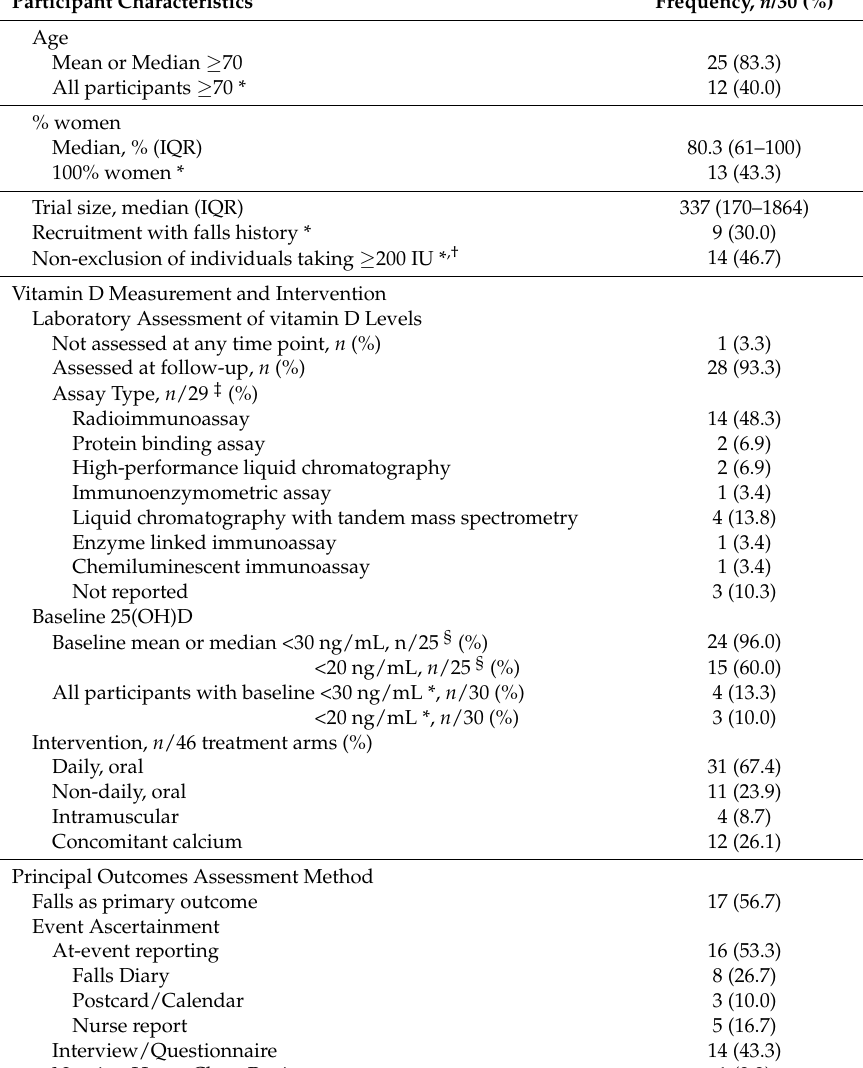
Table 1. Summary of Trial